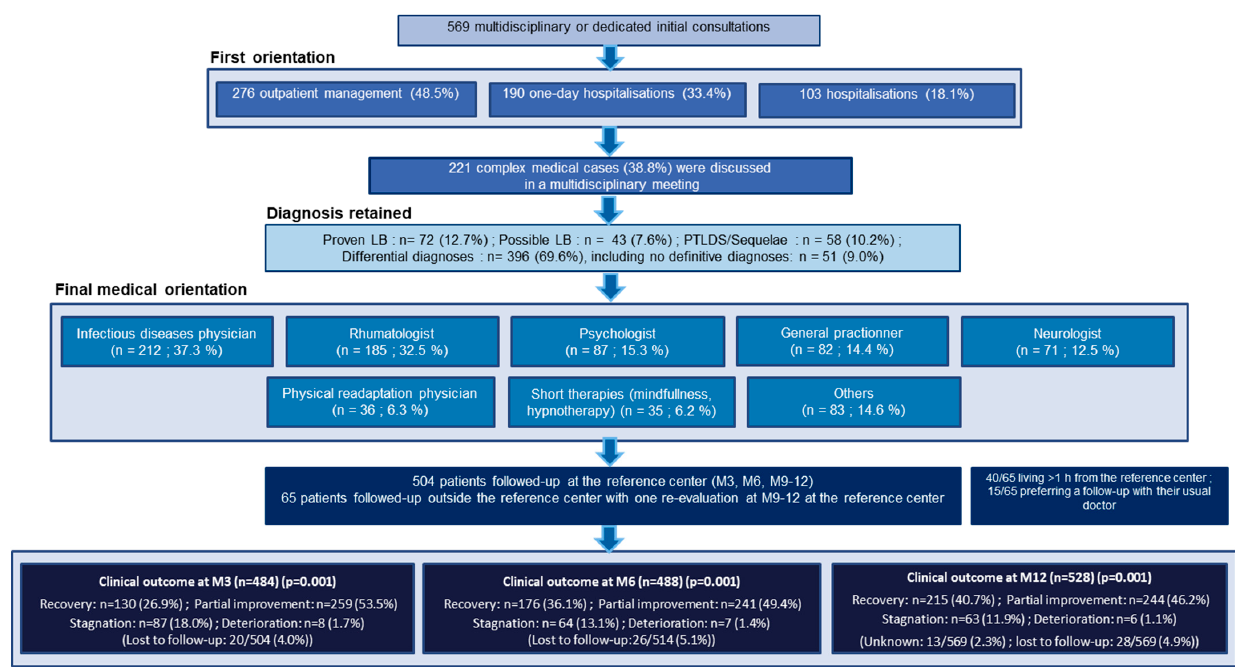
Figure 1. Care paths at the Tick-Borne Diseases Reference Center-Paris and Northern Region.